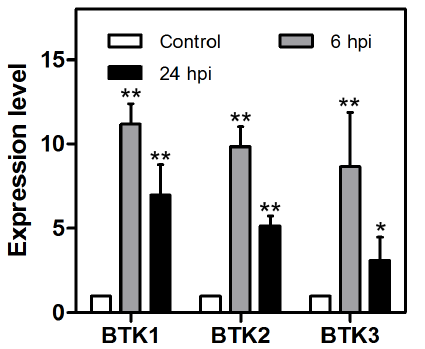
Figure 3. The relative expression level of BTK1, BTK2 and BTK3. The expression level of these genes in uninfected whiteflies was set to 1 (white). Grey and black represent 6 hpi and 24 hpi respectively. Statistical significance compared with Control of P # 0.05 (*) and P # 0.001 (**), Student’s t test. Error bars: 6 SE of the mean.